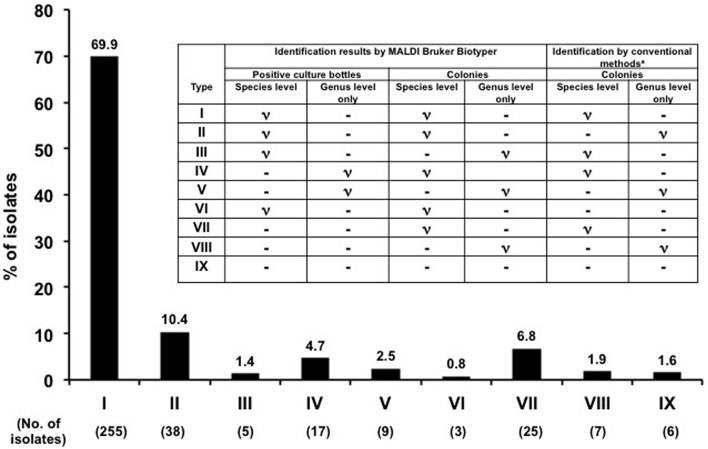
Identification of flagged blood culture bottles by MALDI Biotyper. Comparisons of microbial identification results in 365 monomicrobial flagged blood culture bottles by three methods: flagged culture bottles and subcultured growth colonies from flagged culture bottles by the MALDI Biotyper and conventional identification systems. Patterns of identification (I–IX) were defined based on the identity of identification to the species or genus level among the three methods.